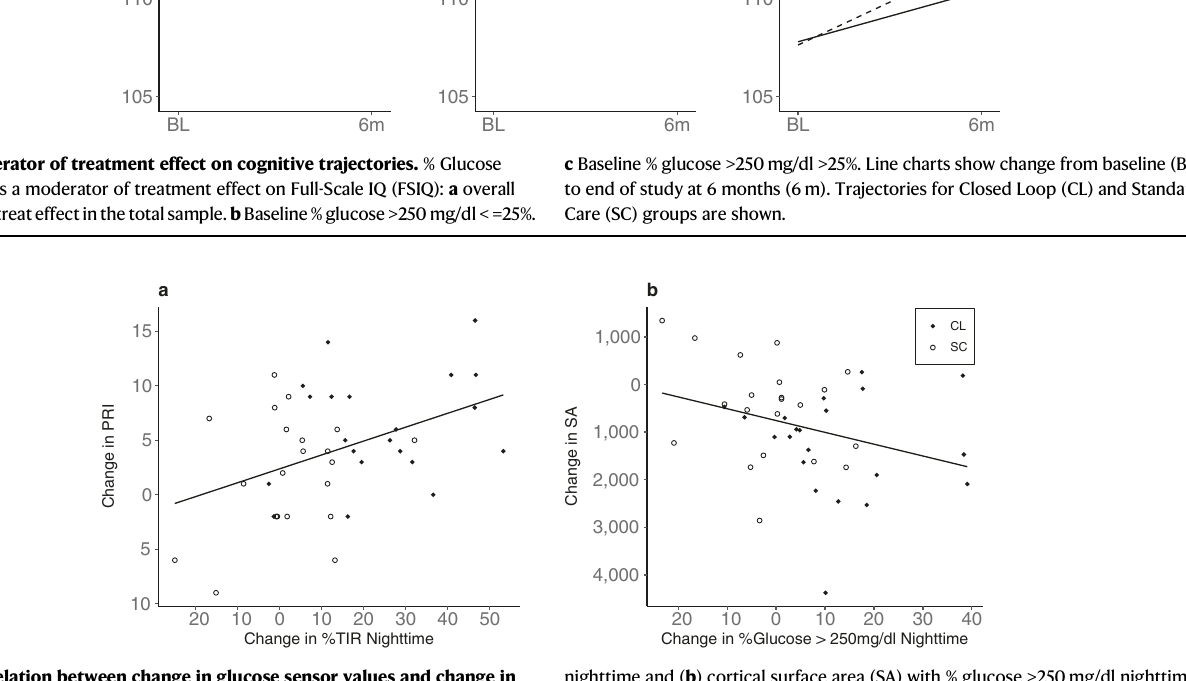
nighttime and ( b ) cortical surface area (SA) with % glucose >250mg/dl nighttime. Closed Loop (CL) group shown by solid diamonds, Standard Care (SC) groups by open